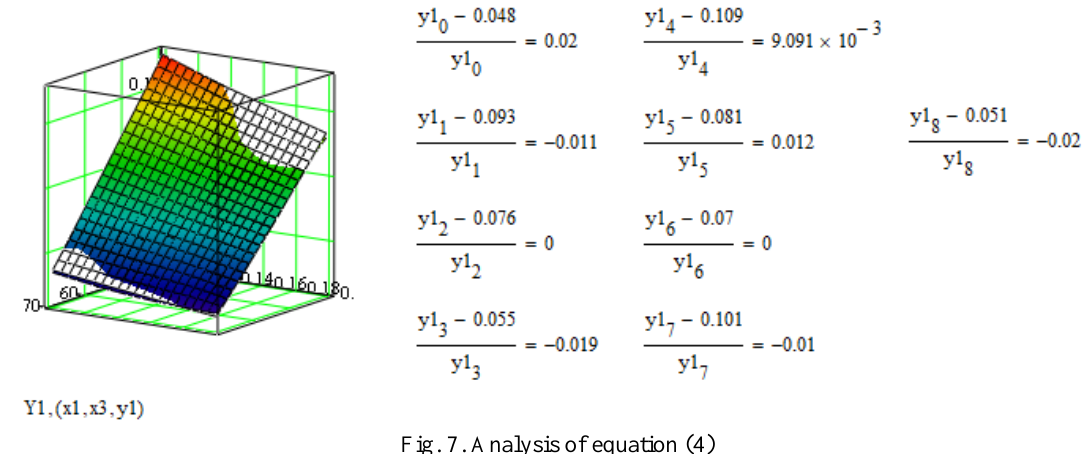
Fig. 7. Analysis of equation